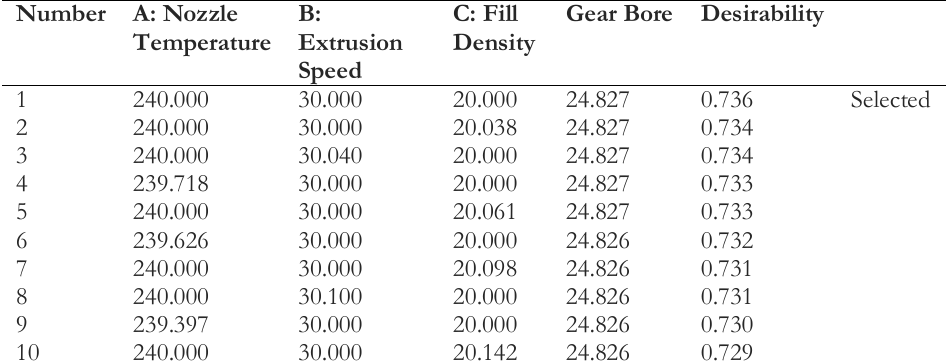
Table 6. Values of process parameters for the optimization of gear bore.